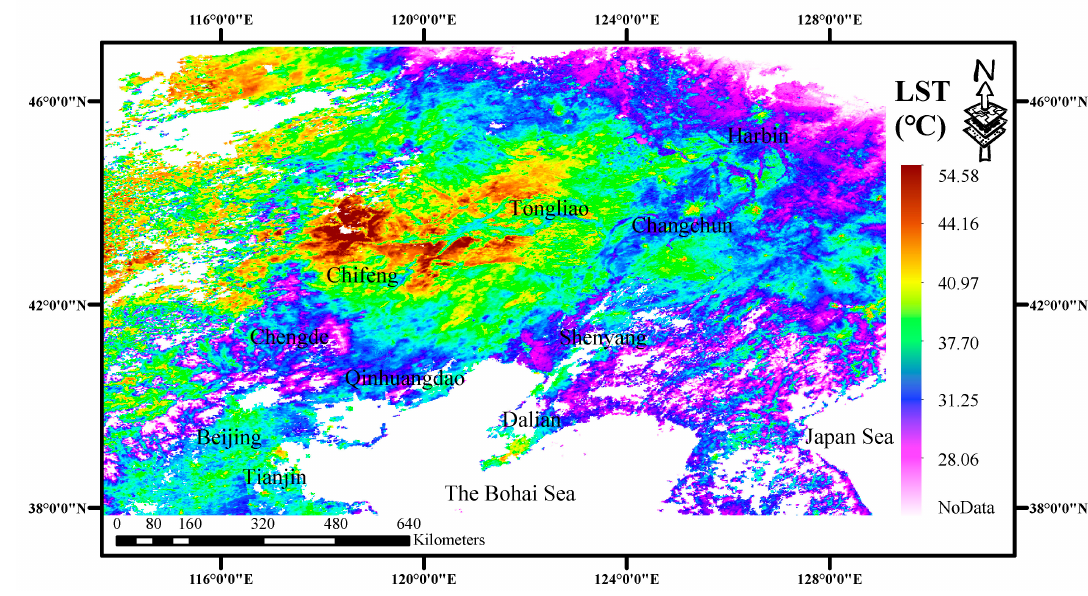
Figure 13. MODIS LST product: MYD11A1 (°C).